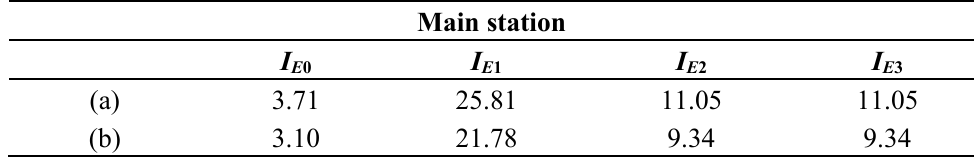
Figure 13. Ground fault currents at main distribution busbars. SPGF at phase “ a ”—Line 1. Table 4. Residual current measurements. SPGF at Line 1—Phase “ a ”— rms current value